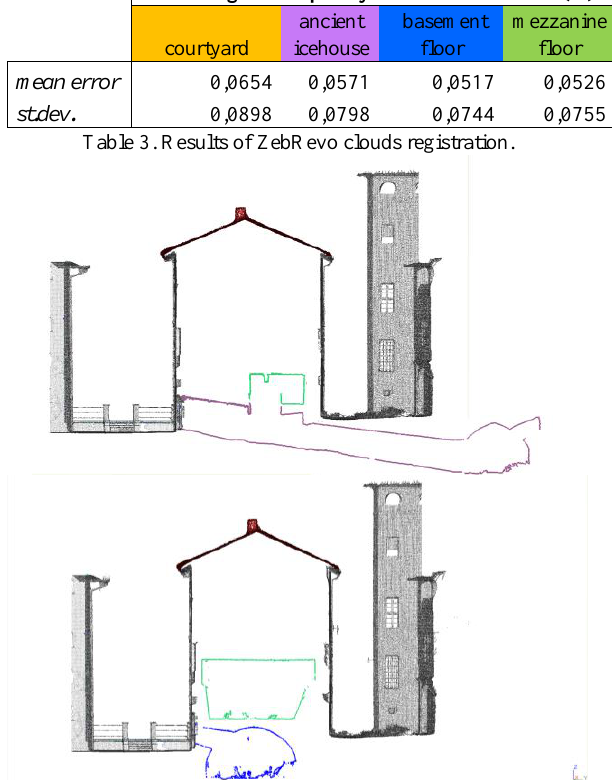
Figure 14. Section profile on UAV, LiDAR and ZebRevo clouds.